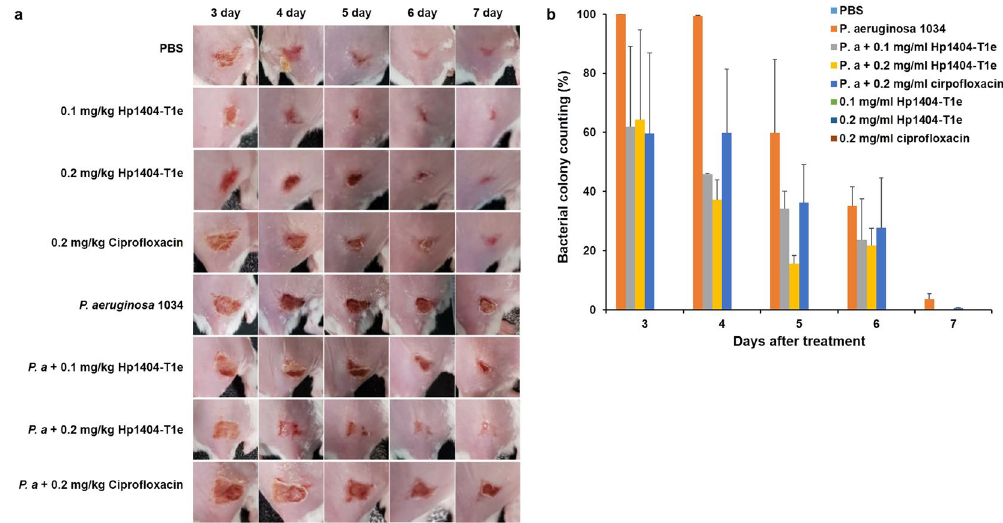
Figure 8. Antibacterial effect of Hp1404-T1e in vivo . ( a ) Image of the infected skin after 3, 4, 5, 6, or 7 days. ( b ) Percentage of bacterial colonies in P. aeruginosa infected skin. Hp1404-T1e was used at a concentration of 0.1 mg/ml and 0.2 mg/ml after P. ae ruginosa 1034